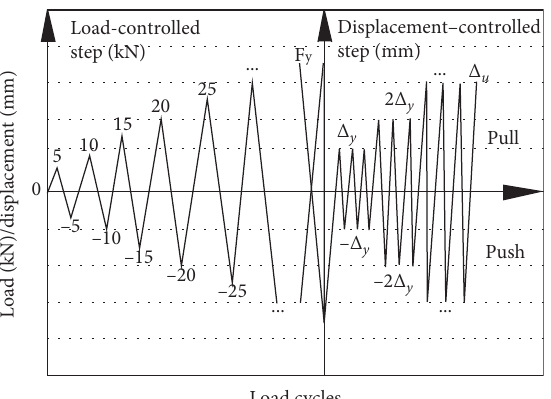
Figure 5: Loading